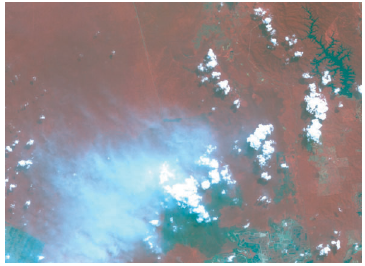
Figure 4.4. Image of the same area in peninsular Malaysia acquired on July 10, 2001. Scale is approx- imately 1 : 0 .